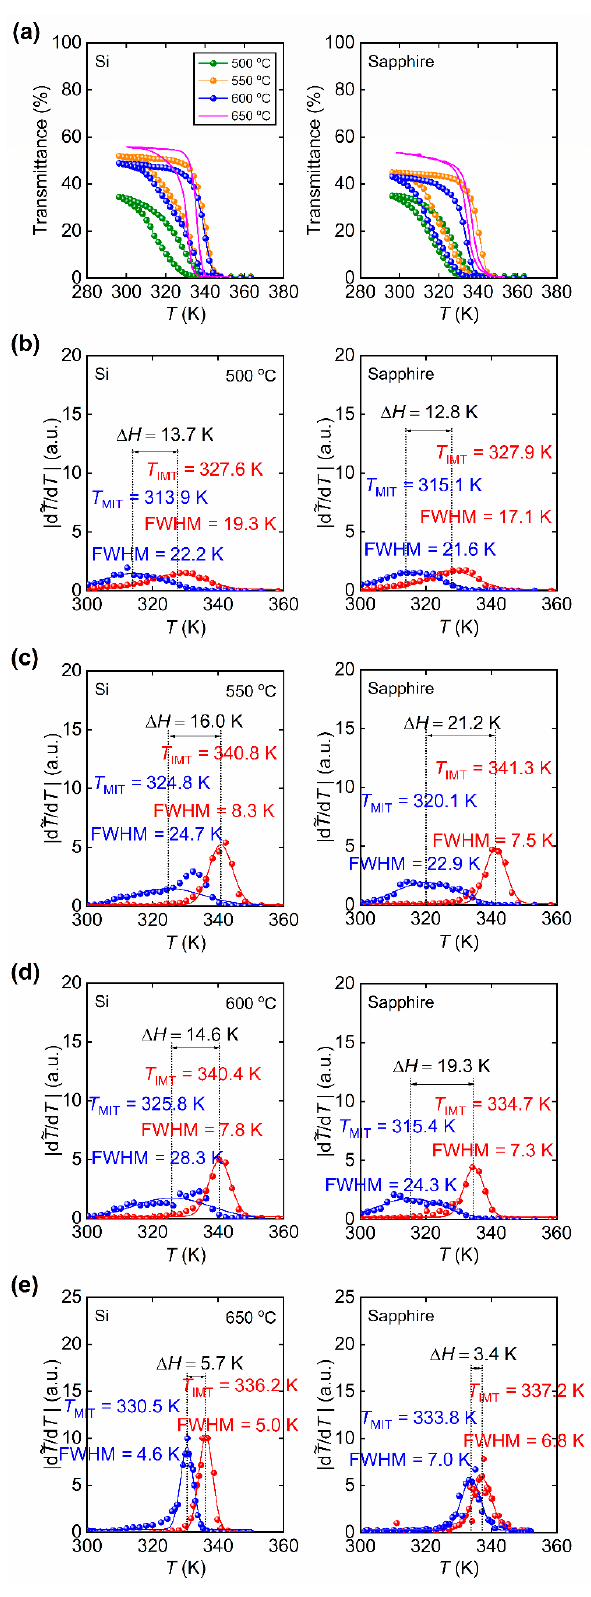
Figure 7. ( a ) Temperature dependence of optical transmittance ( T ) obtained at a light wavelength of λ = 2500 nm for VO 2 thin films deposited at 500, 550, 600 and 650 ◦ C [17]. The phase transition characteristics for heating and cooling cycles for films prepared at ( b ) 500 ◦ C, ( c ) 550 ◦ C, ( d ) 600 ◦ C, and ( e ) 650 ◦ C [17] on Si and sapphire substrates at 300 K (insulating phase) and 368 K (metallic